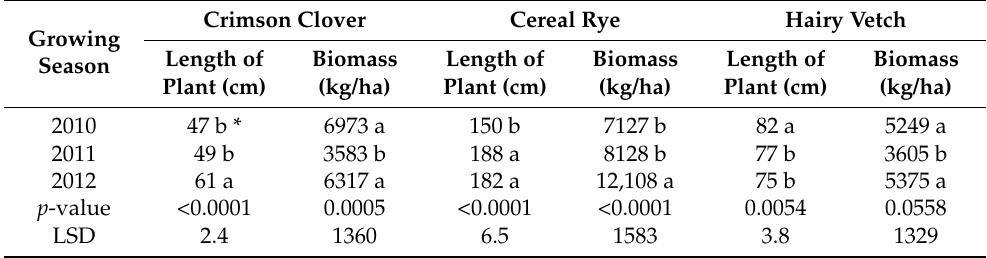
Table 3. Plant height and biomass for crimson clover, cereal rye, and hairy vetch cover